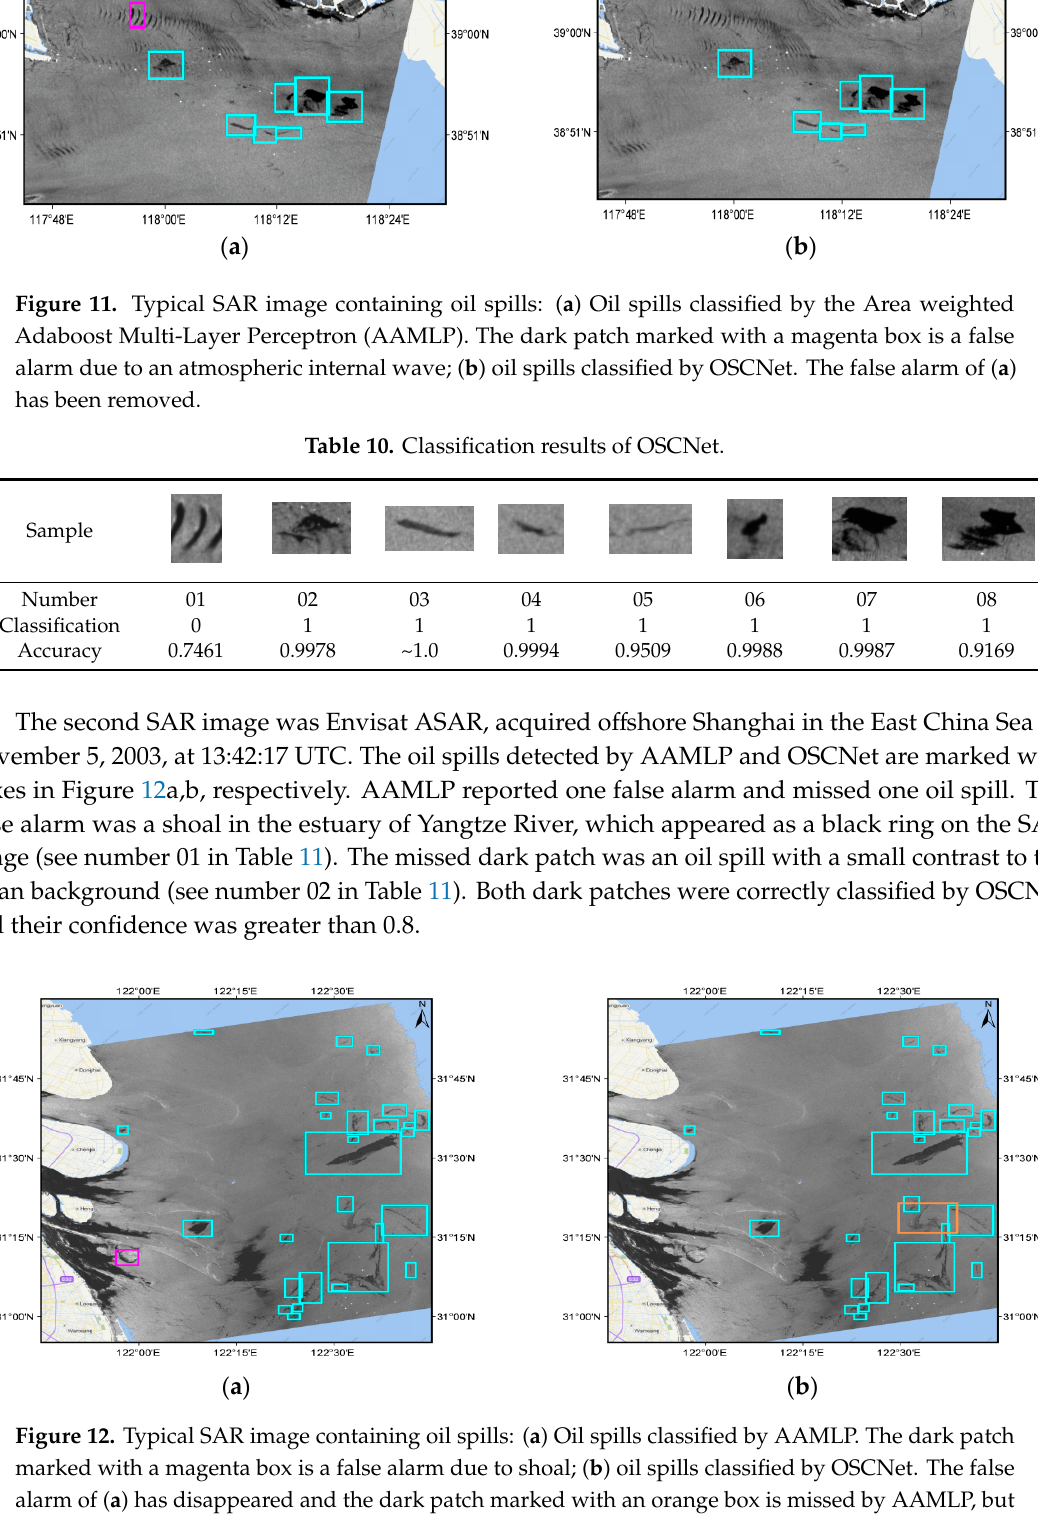
Figure 12. Typical SAR image containing oil spills: ( a ) Oil spills classified by AAMLP. The dark patch marked with a magenta box is a false alarm due to shoal; ( b ) oil spills classified by OSCNet. The false alarm of ( a ) has disappeared and the dark patch marked with an orange box is missed by AAMLP, but correctly classified by OSCNet. Table 11. The dark patches misclassified by AAMLP, but correctly classified by OSCNet.